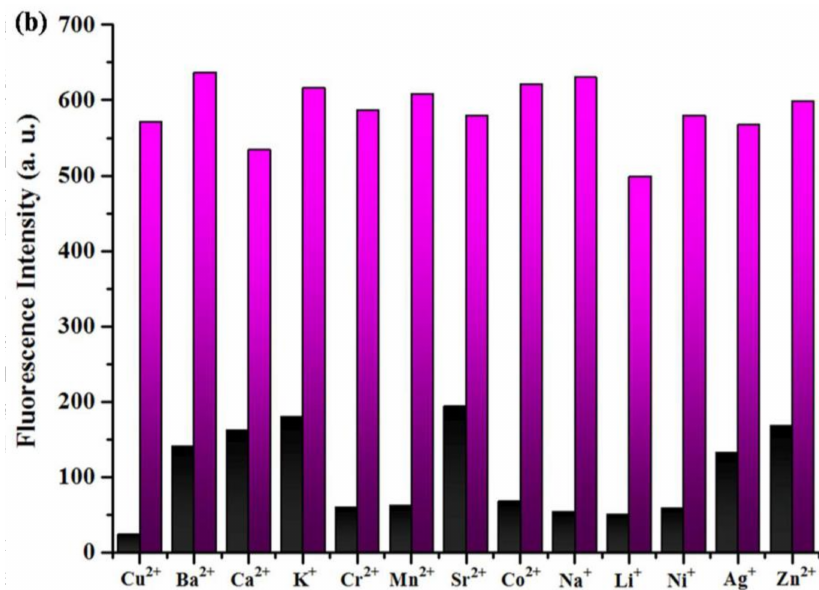
Figure 4. ( a ) Fluorescent spectra and ( b ) fluorescent intensity at 323 nm of sensor H 4 L (1 × 10 − 5 M) in the existence of different metallic ions (c = 1 × 10 − 3 M, excess amounts Cu 2+ , Ba 2+ , Ca 2+ , K + , Cr 3+ , Mn 2+ , Sr 2+ , Co 2+ , Na + , Li + , Ni 2+ , Ag + , and Zn 2+ ) in Tris-phosphate buffer (c = 0.2 M, DMF/H 2 O = 9:1, v / v , pH = 7.0, λ ex = 323 nm) solution (the black bars delegate the addition of excess amounts of metallic ions to the solution of probe H 4 L and the pink bars delegate the subsequent addition of Cd 2+ to the mixed